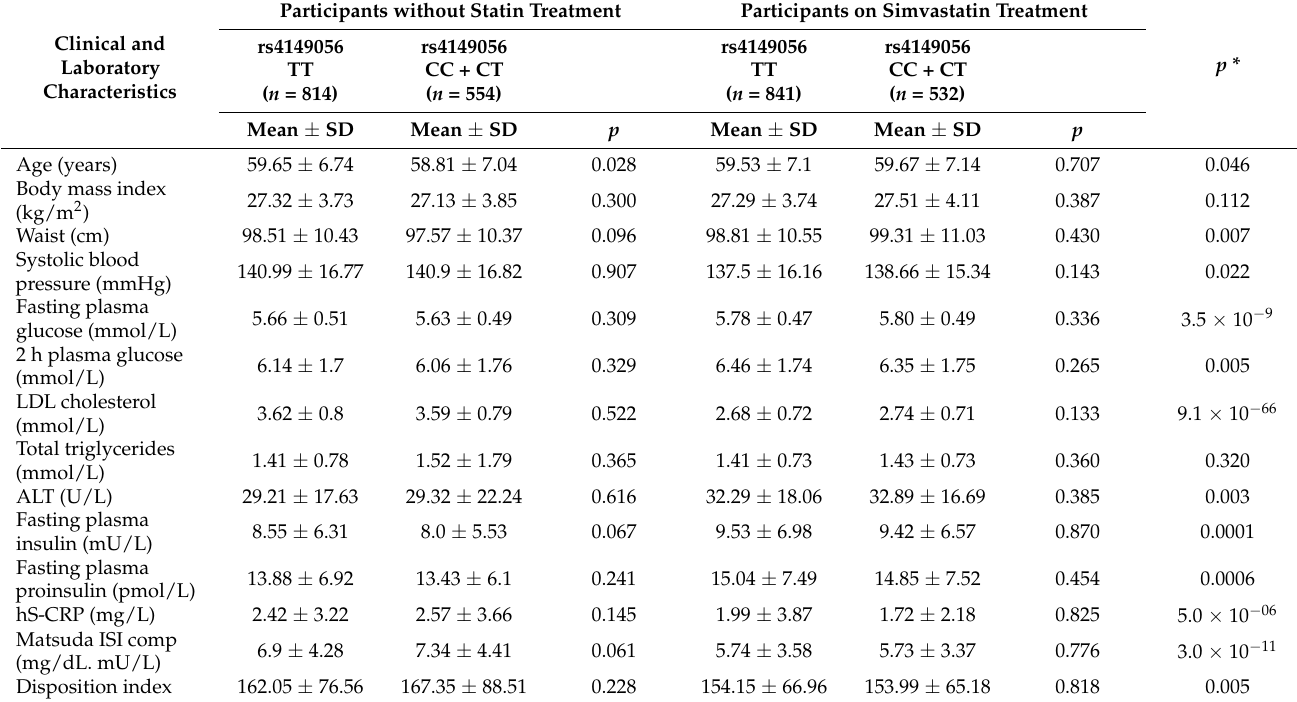
Table 1. Clinical and laboratory characteristics at baseline of participants without statin treatment and participants on simvastatin treatment based on SLCO1B1 rs4149056 genotypes.